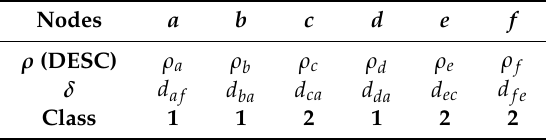
Table 1. The local density and distance of six nodes. Nodes